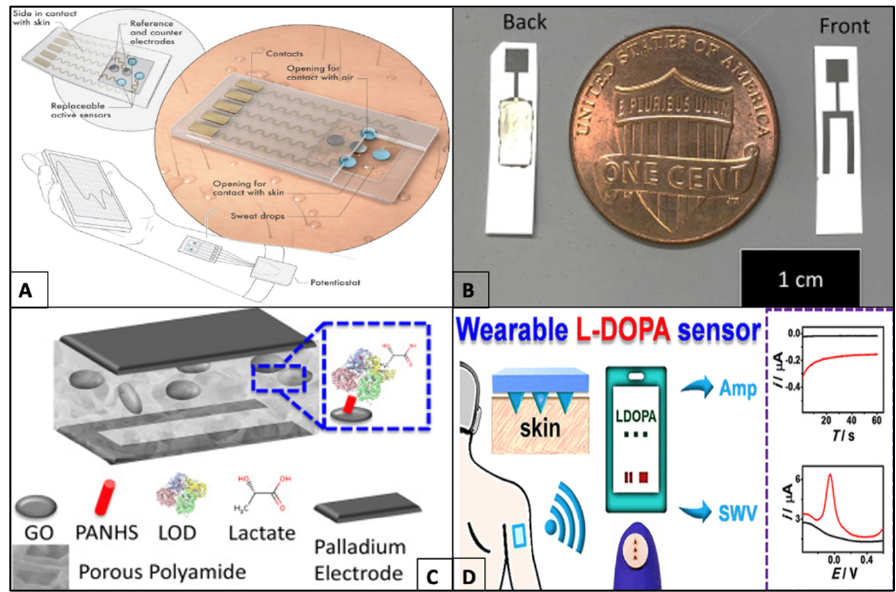
Figure 3. Examples of wearable electrochemical sensors. ( A ) Schematic illustration of the 2D MXene- based sweat sensor system showing the arrangement of electrodes, sweat uptake system, and